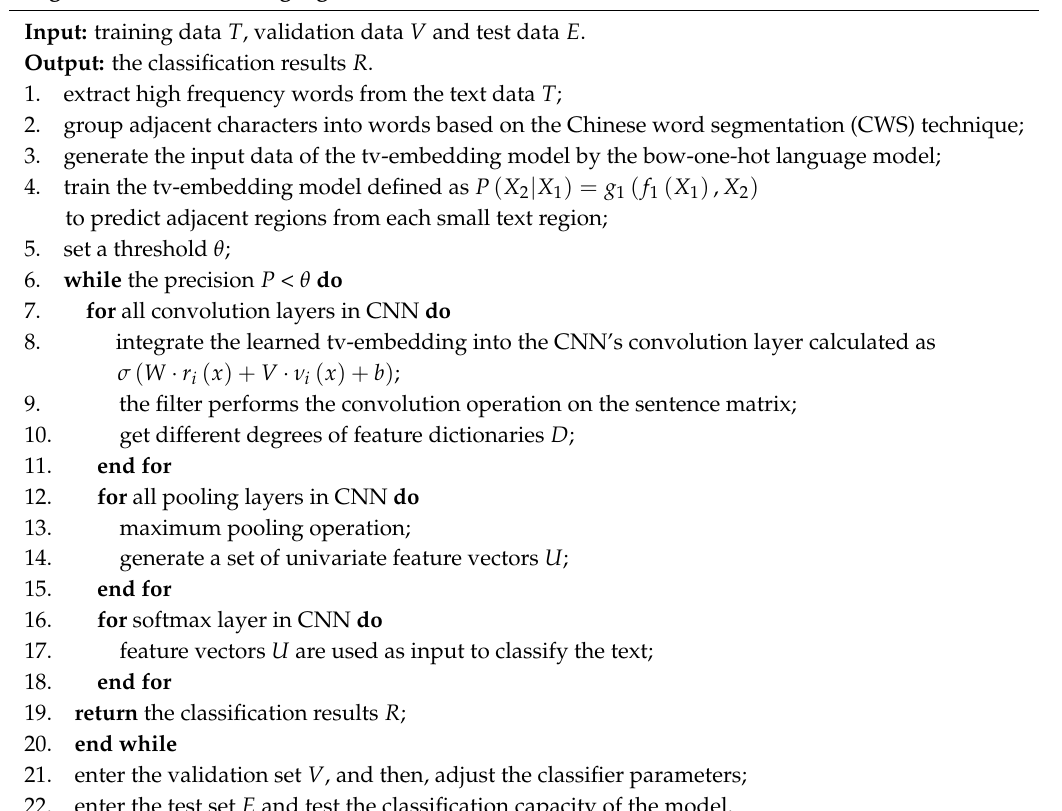
Algorithm 1: SSC training